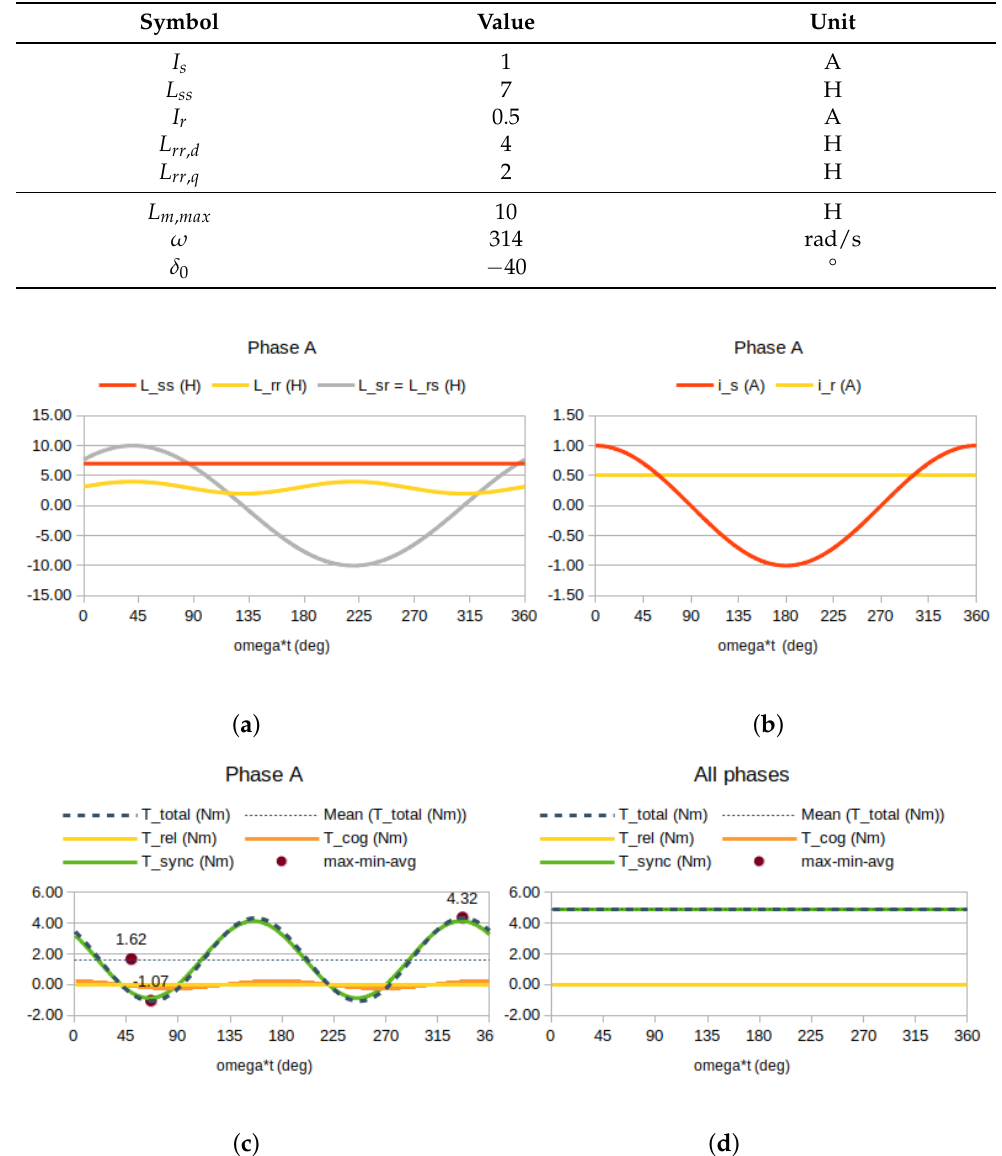
Table 3. Rated values of the motor for the preliminary torque analysis.